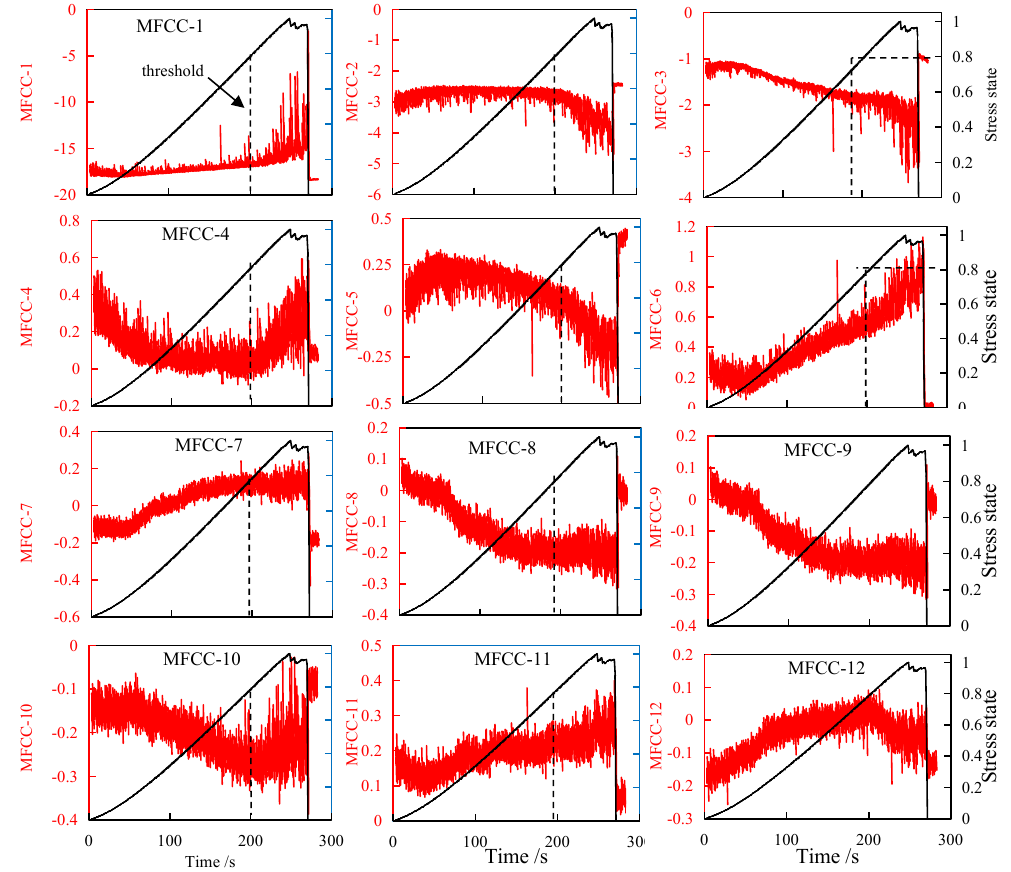
Figure 6. Variation of MFCC of AE with respect to stress state of the coal specimen No. aD8-5 sub- jected to uniaxial compression.